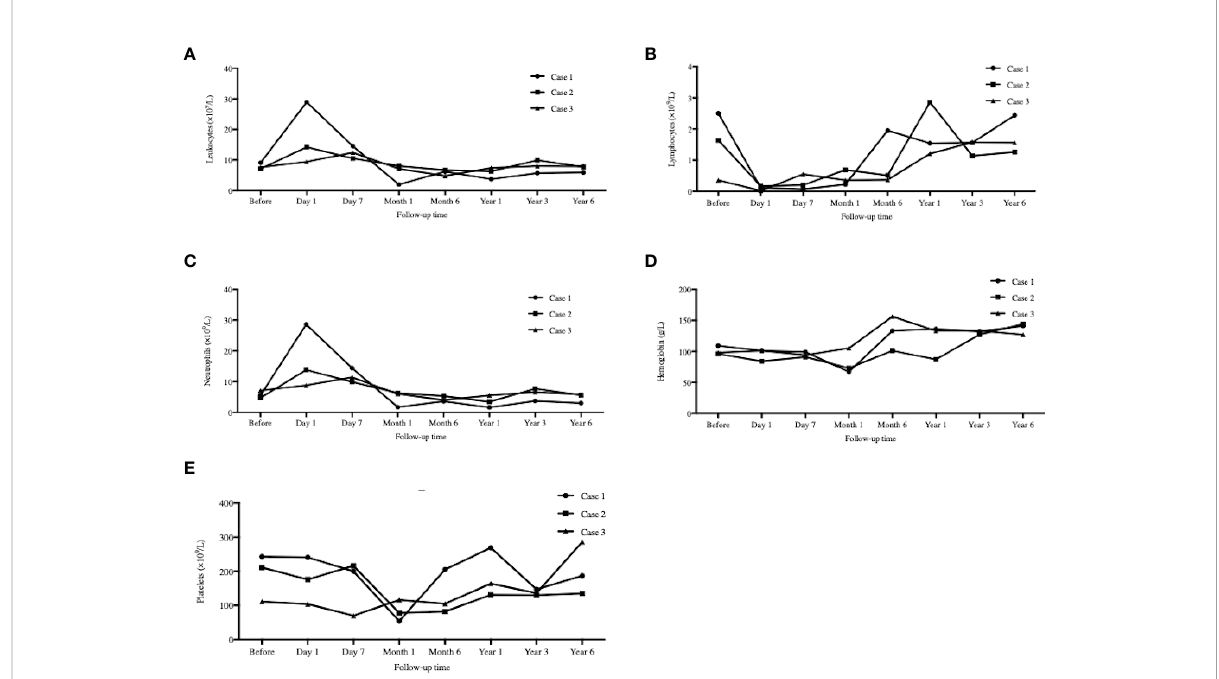
FIGURE 6 Peripheral blood cell counts mornitoring. The serial peripheral blood cell counts monitoring at day 1, day 7 and 1, 6, 12, 36, 72 months after transplantation. (A) : Leukocytes; (B) Lymphocytes; (C) : Neutrophils; (D) : Hemoglobin; (E) : Platelets. All types of blood cells decreased after transplantation (except ncutrophils), and then gradually